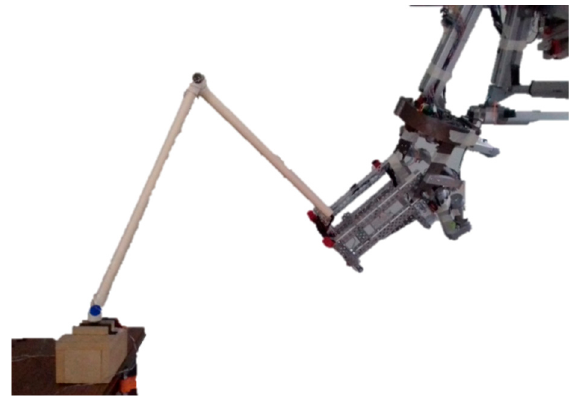
Figure 5. Configuration for position reading in ERMIS.